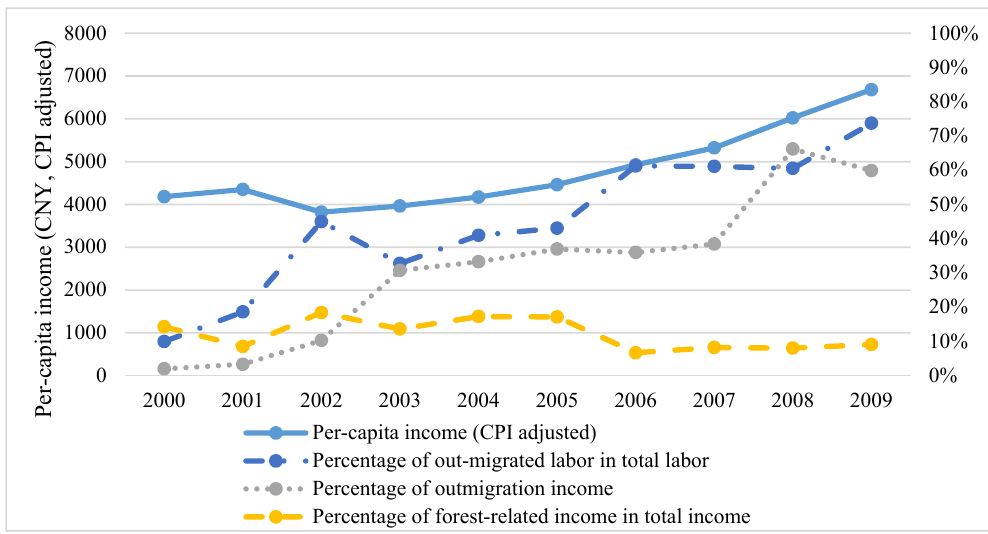
Figure 4. Outmigration, income increase, and income diversification. Note: Data is derived from the Rural Economy Statistical Form and the Rural Economy Benefit-sharing Statistical Form.